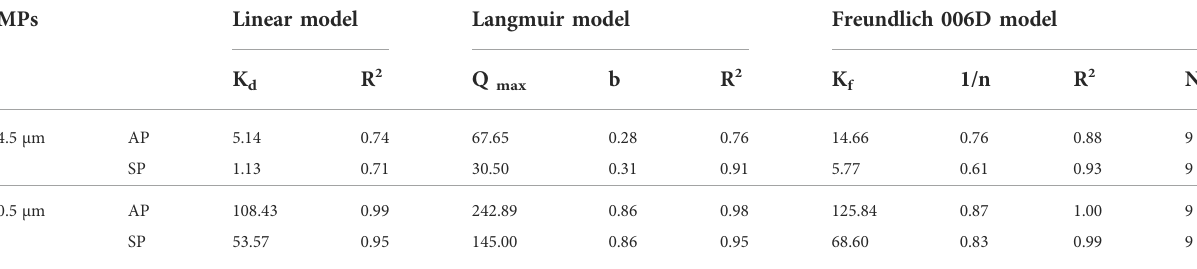
TABLE4EstimatedparametersfortheLinear,Langmuir,andFreundlichmodelsexplainingthesorptionofB(a)PtoMPsofdifferentsizes,accordingto data obtained from the aqueous phase (AP) or solid phase (SP). MPs